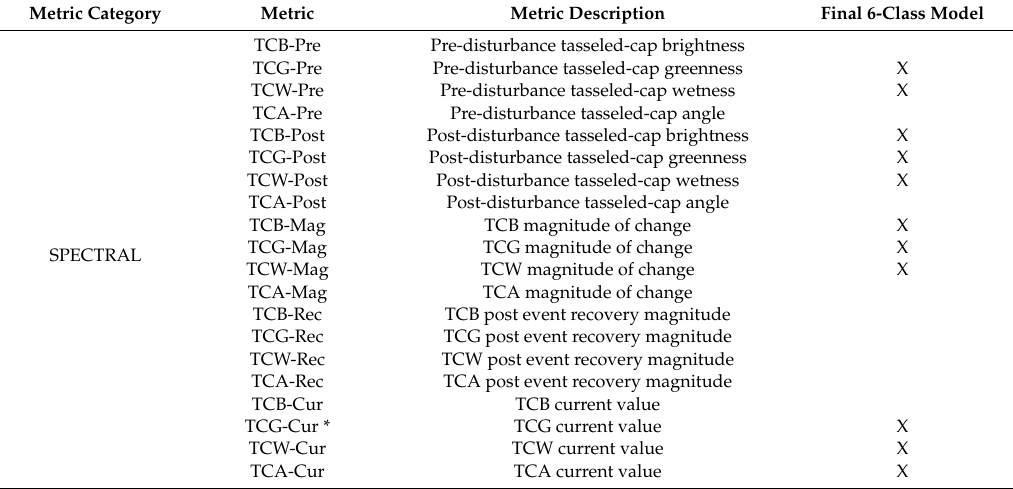
Table 1. Disturbance agent random forest classification model predictors with designations for those retained in the final model following variable reduction procedures. The top three metrics from random forest metric importance rankings are marked with an